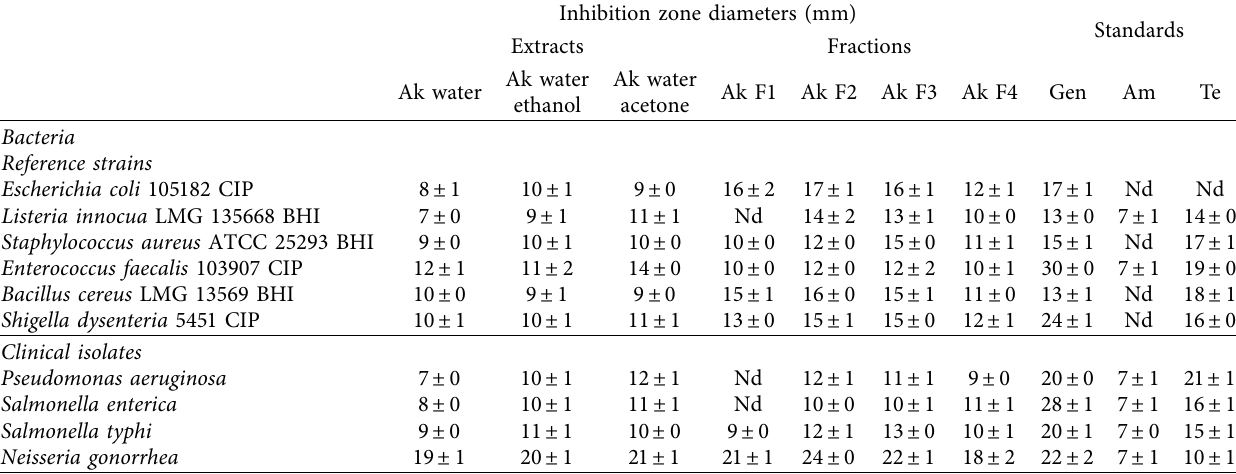
Table 2: Inhibition zone diameters produced by the extracts and fractions from Antrocaryon klaineanum